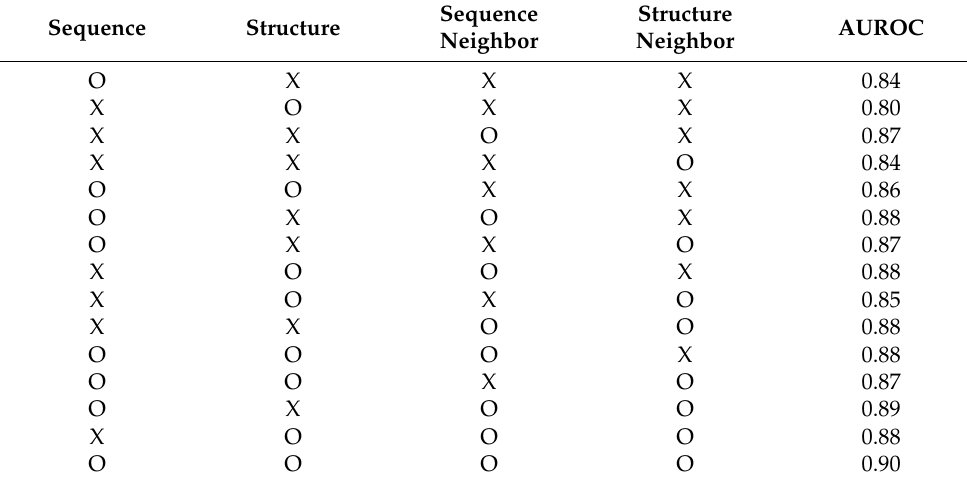
Table 4. Results of ablation study on feature